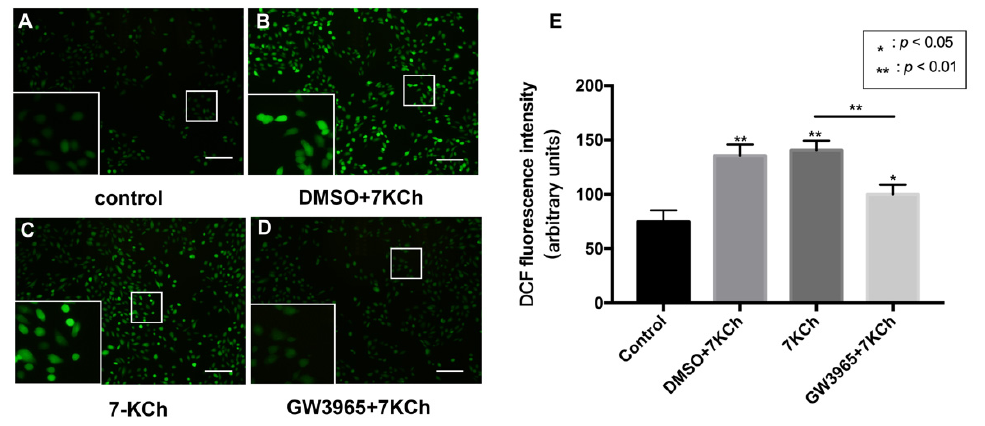
Figure 6. ROS levels of ARPE-19 cells. ( A ) As a control, ARPE-19 cells were cultured with a serum- free medium for 48 h. ( B ) ARPE-19 cells were incubated with DMSO (0.02%) for 24 h, followed by 7KCh (20 µ M) for 24 h. ( C ) ARPE-19 cells were cultured with serum-free medium for 24 h and then incubated with 7KCh (20 µ M) for 24 h. ( D ) ARPE-19 cells were incubated with GW3965 (2 µ M) for 24 h, followed by 7KCh (20 µ M) for 24 h. The apoptosis of ARPE-19 cells was measured by ROS detection. Scale bar 100 µ m. ( E ) DCF fluorescence intensity was quantified with Image J. Data are represented as mean ± SEM of three independent experiments. Differences with p < 0.05 were considered statistically significant.